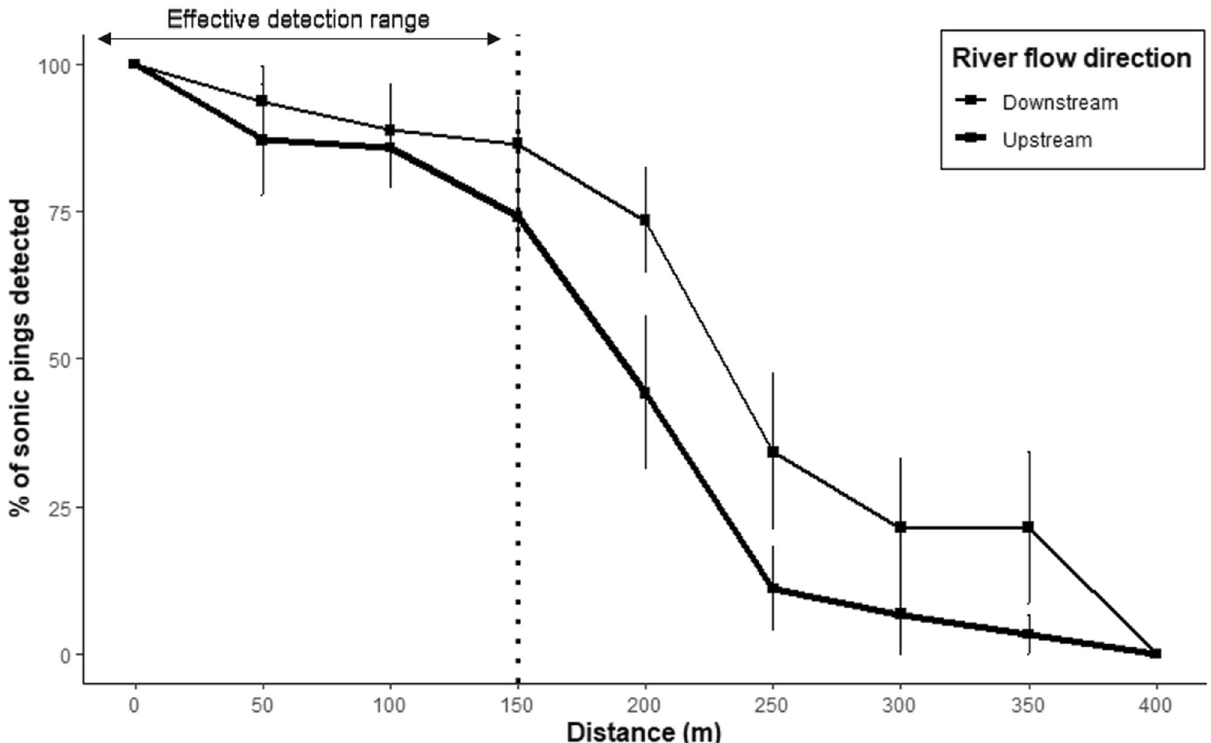
Figure 2. Effective range of pingers. Until 150 m, the average % of sonic pings detected in the CPOD is 89.5 ± 2.4 SE and the average beyond 150 m is 24.6 ± 4.4 SE.